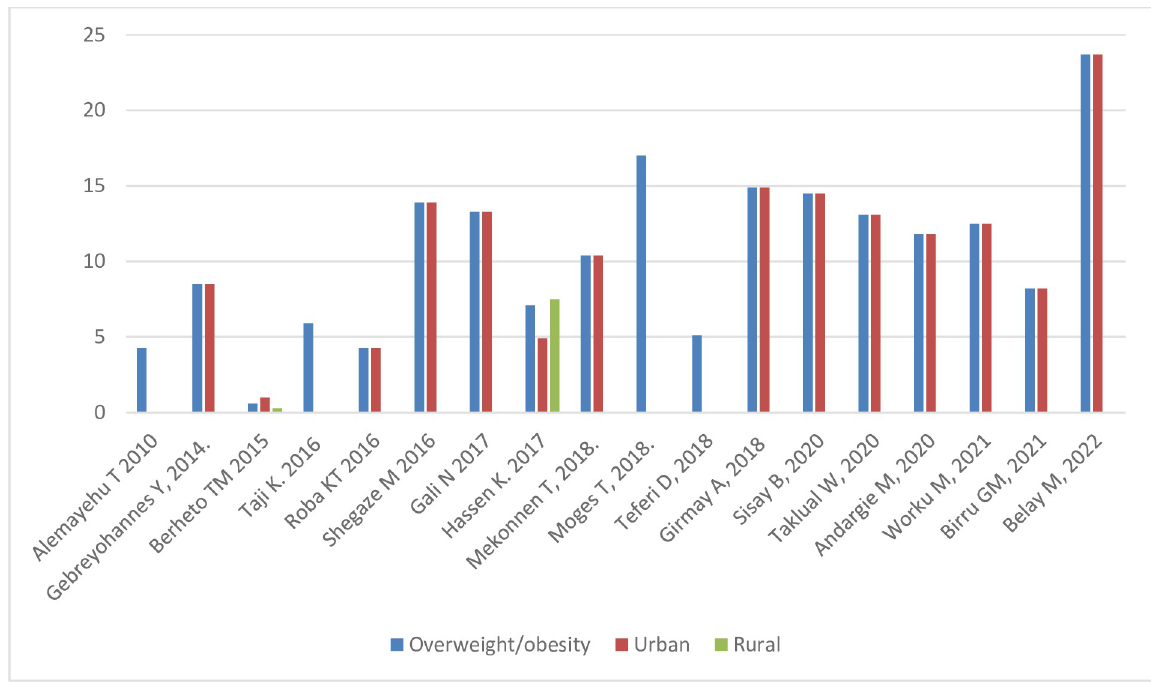
Fig 11. Trends in adolescent overnutrition by setting in Ethiopia over the last 10 years.